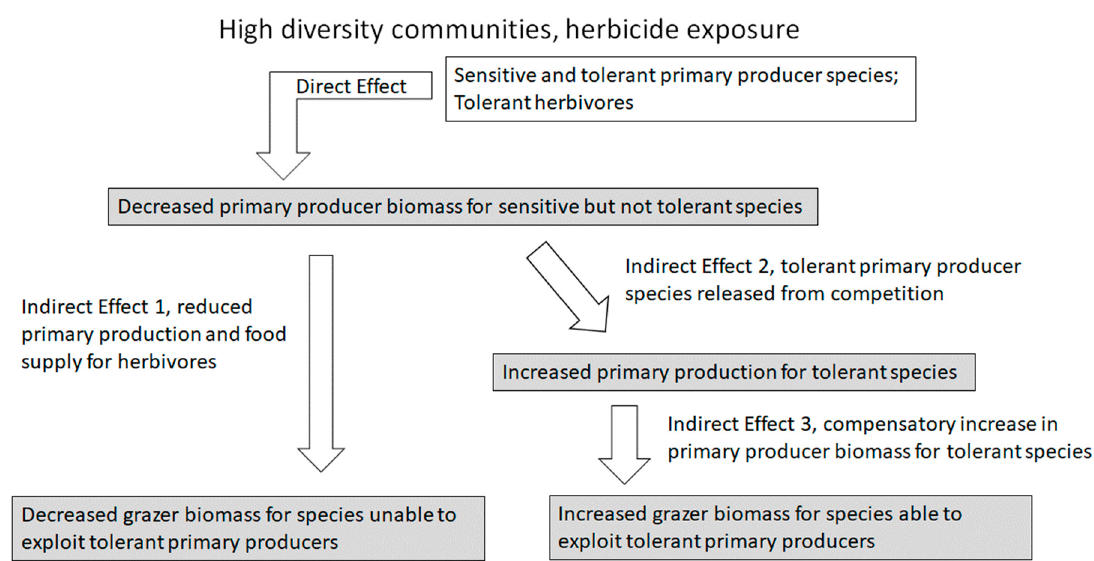
Figure 3. One scenario for indirect effects in a diverse community with relatively sensitive and relatively tolerant primary producer species exposed to an herbicide. In this case, indirect effects may be mild but will be difficult to predict, and they will vary depending on species composition and with changes in environmental conditions. Ecosystem state changes caused by direct and indirect effects are described in shaded boxes.